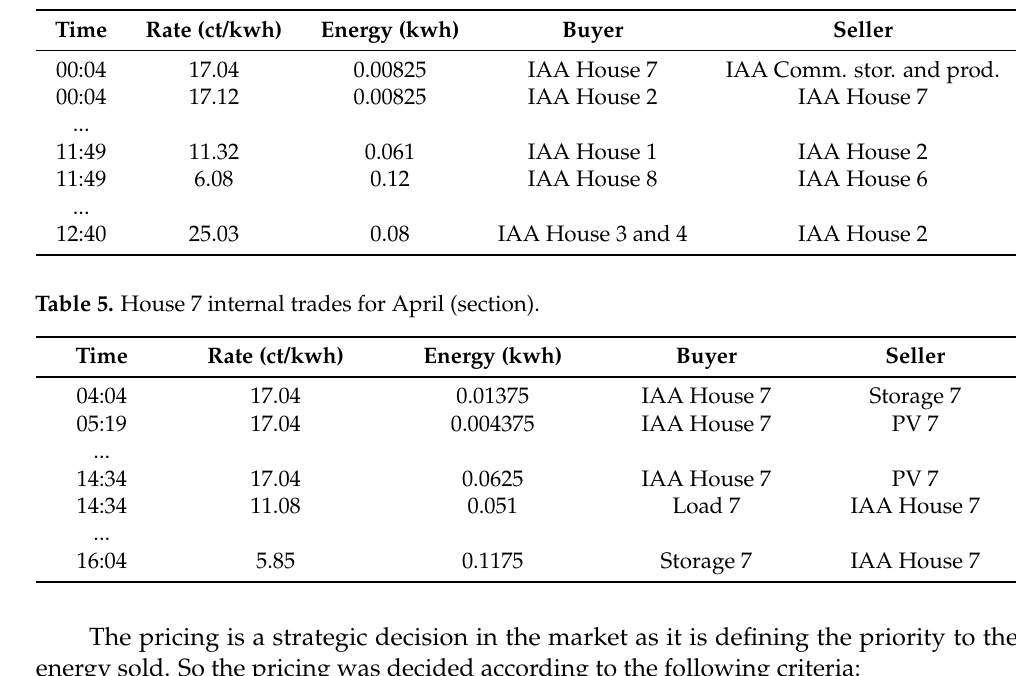
Table 4. LMRA grid trades for April (section).